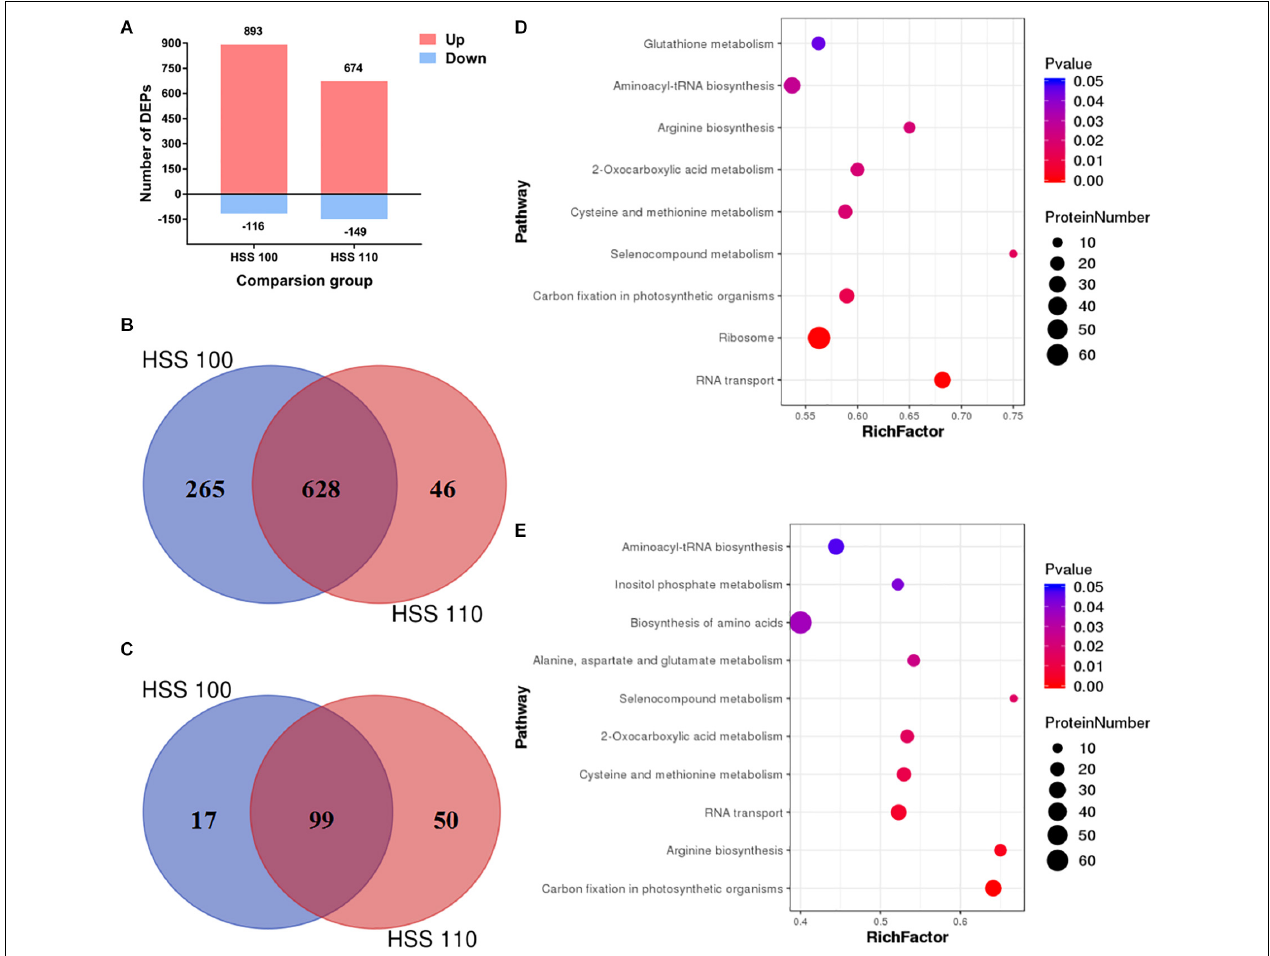
FIGURE 2 | Analysis of differentially abundant proteins in P. haitanensis exposed to hypersaline stress for 4 h. (A) Number of differentially abundant proteins in each comparison. (B) Venn diagram of differentially abundant proteins (increased abundance). (C) Venn diagram of differentially abundant proteins (decreased abundance). (D) KEGG classification of differentially abundant proteins under HSS 100 conditions. (E) KEGG classification of differentially abundant proteins under HSS 110 conditions. FC ≥ 1.5 and P <